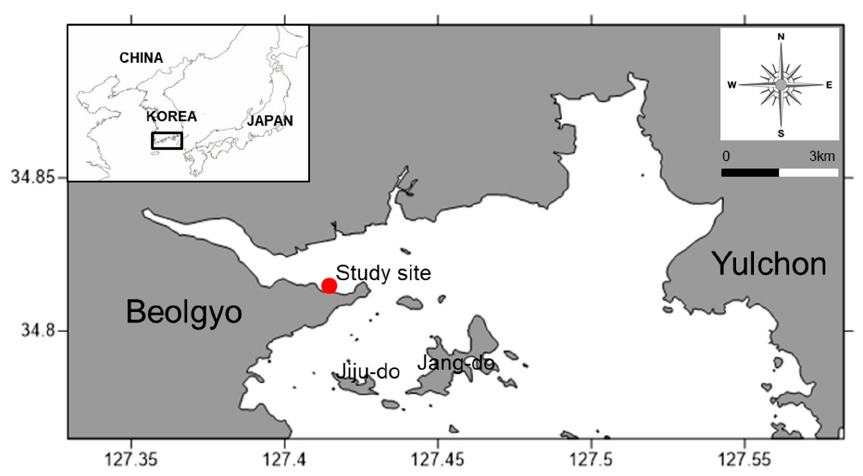
Figure 1. Map showing the study site located in the northwestern Yeoja Bay of Korea. Table 1. The in situ conditions of this study area.